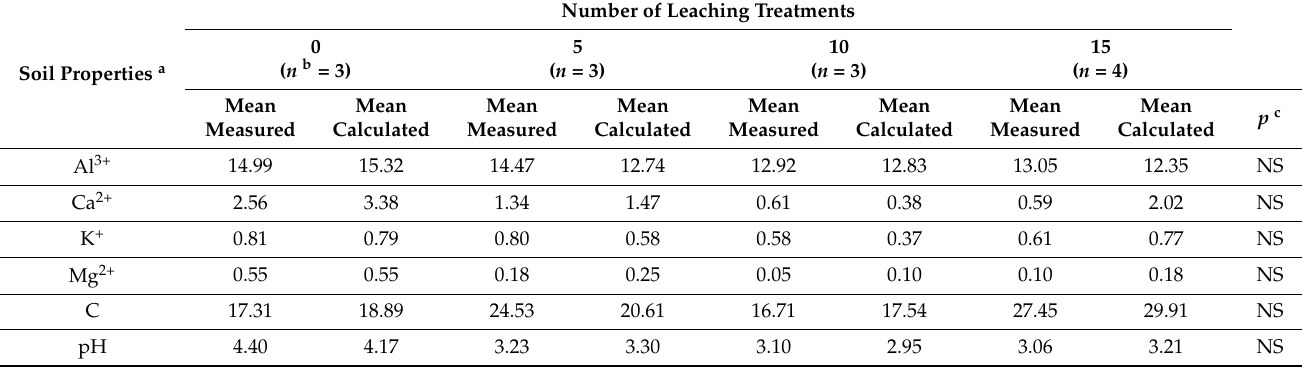
Table 3. NIR spectroscopy results for the validation of soils under beech stands (measured versus calculated values, p ).